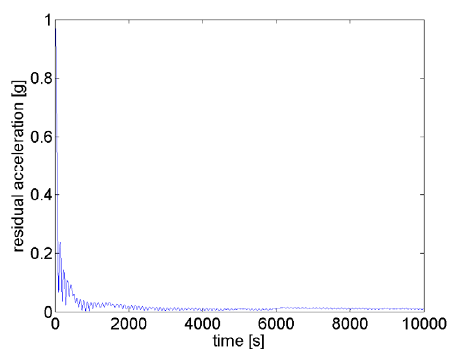
Figure 9. The residual gravity for planned trajectory approaches roughly 0.01 g after a few hundred seconds (nullification).